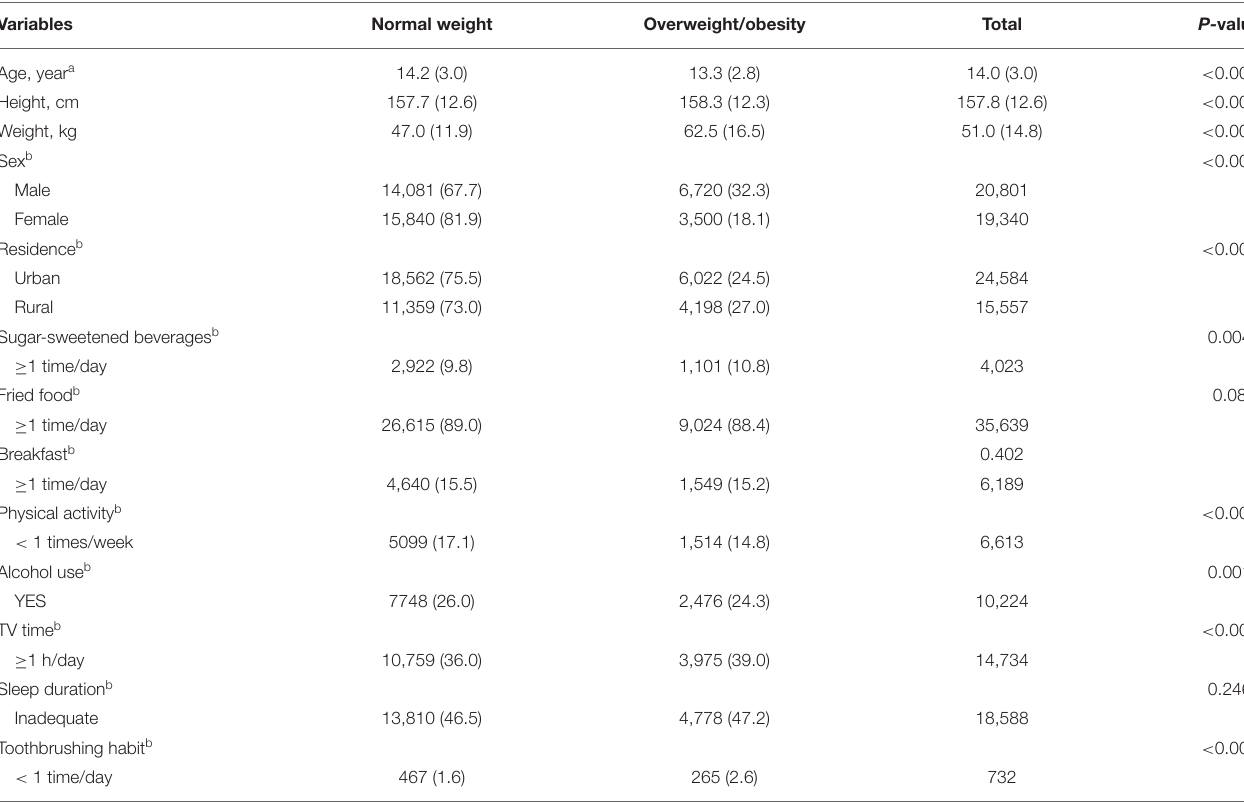
TABLE 1 | Participants’ demographic characteristics and lifestyle